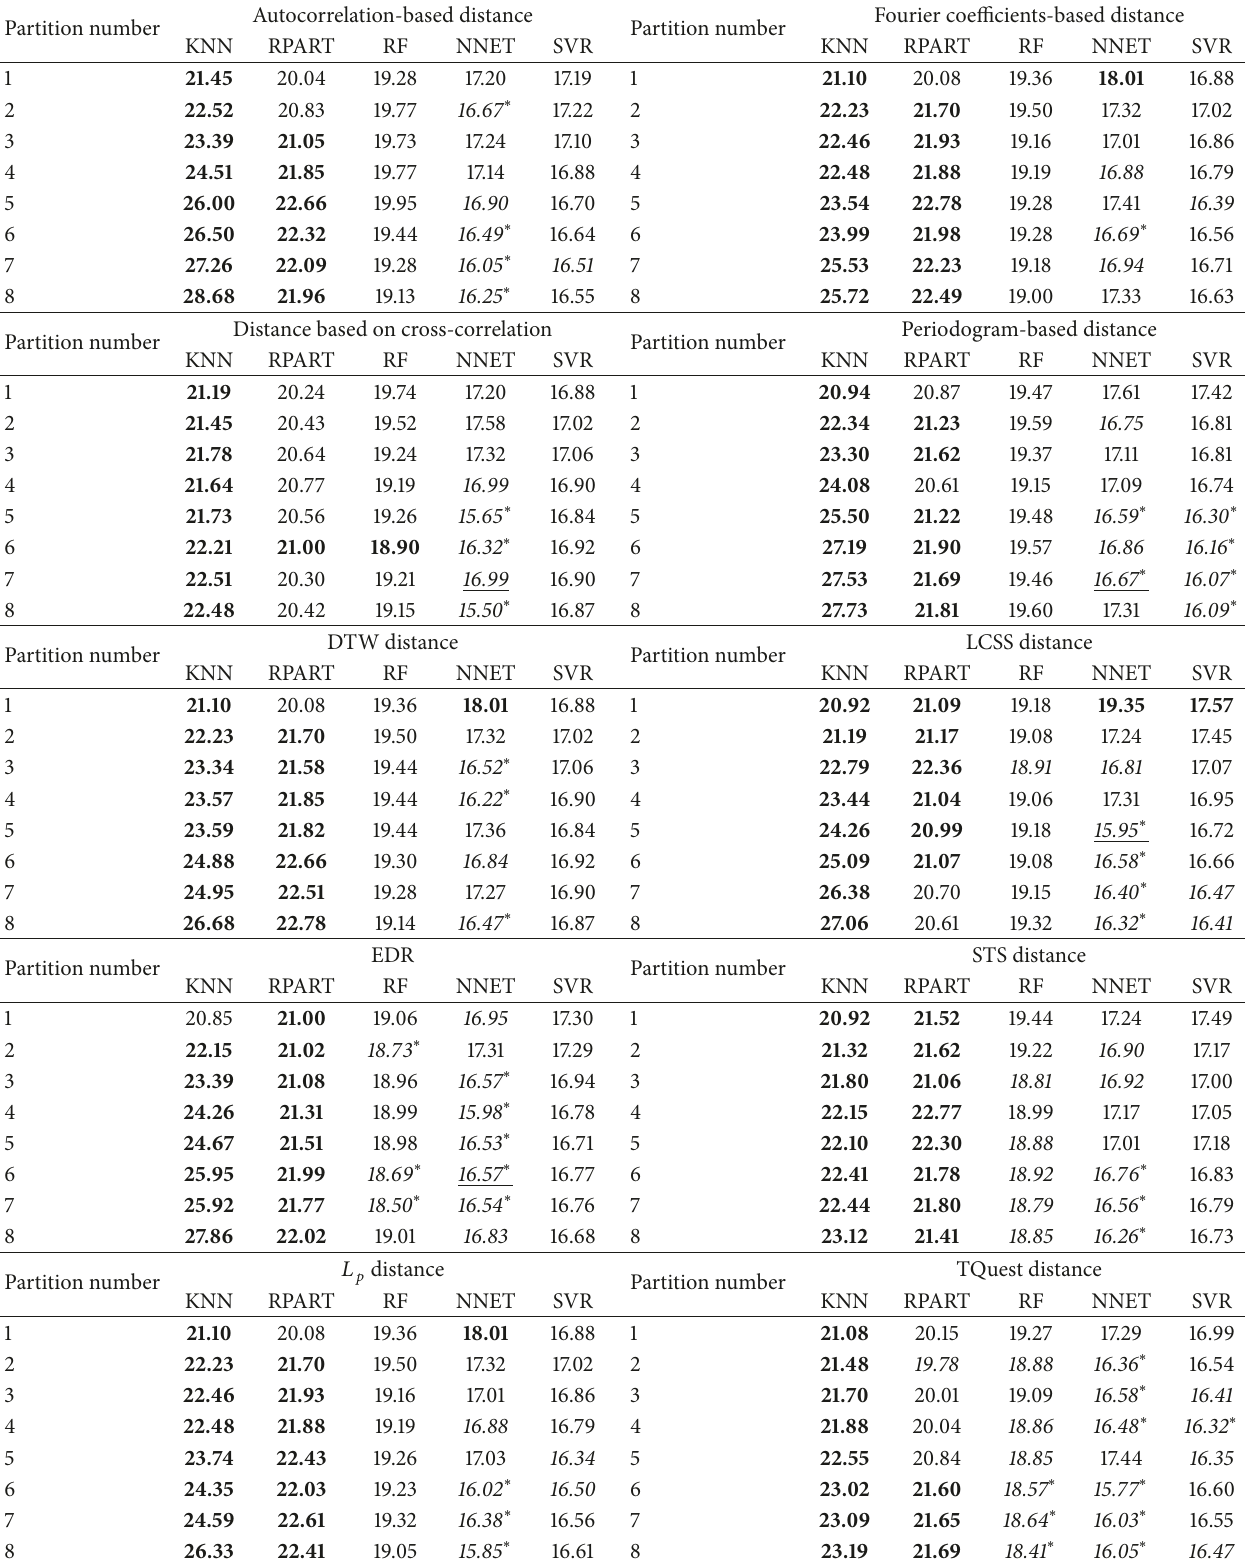
Table 7: Forecasting results in terms of MAPE error for grouped households using the test